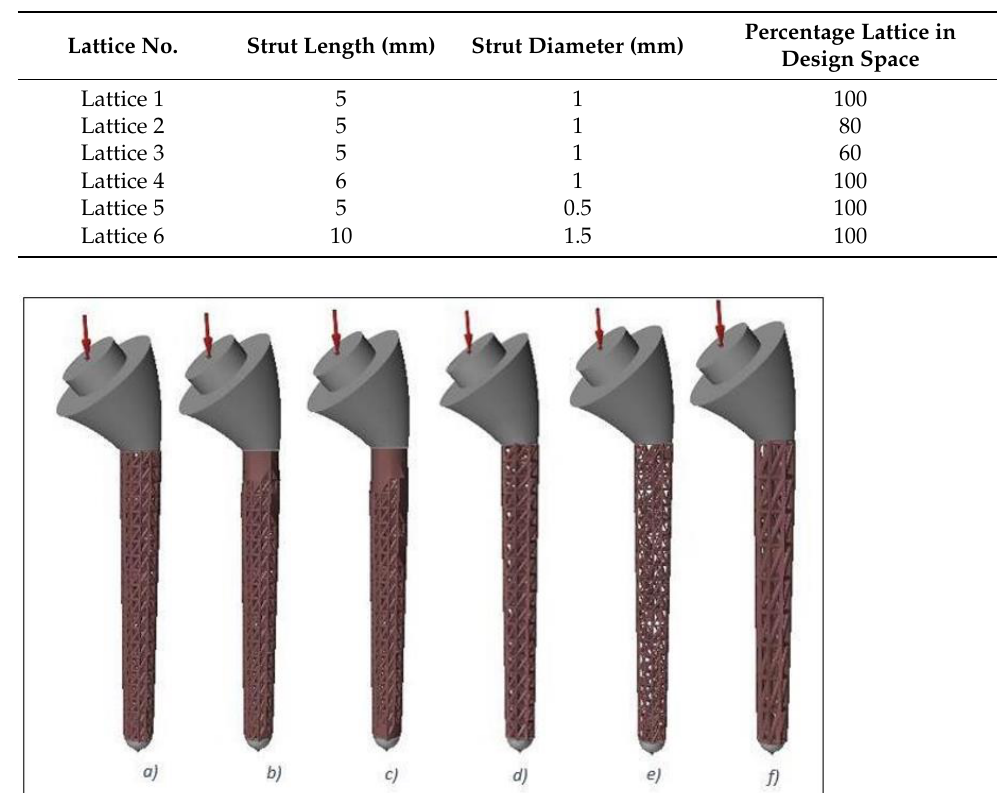
Table 2. Six face-centred cubic lattice topologies with optimised geometries and their corresponding parameters.